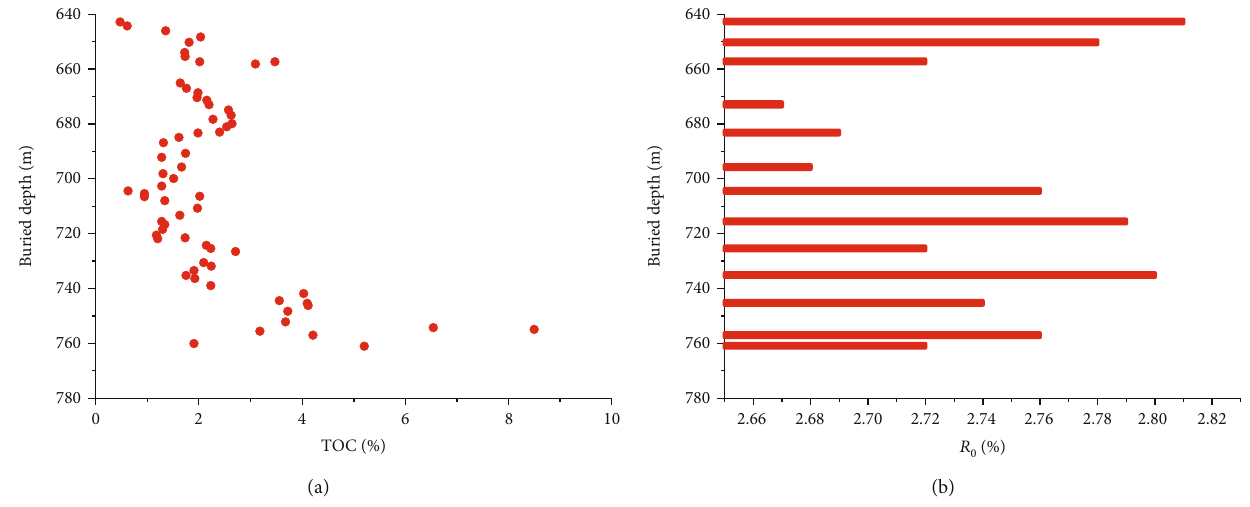
Figure 9: TOC content (a) and R o value (b) of WL shale in Well-YC4.